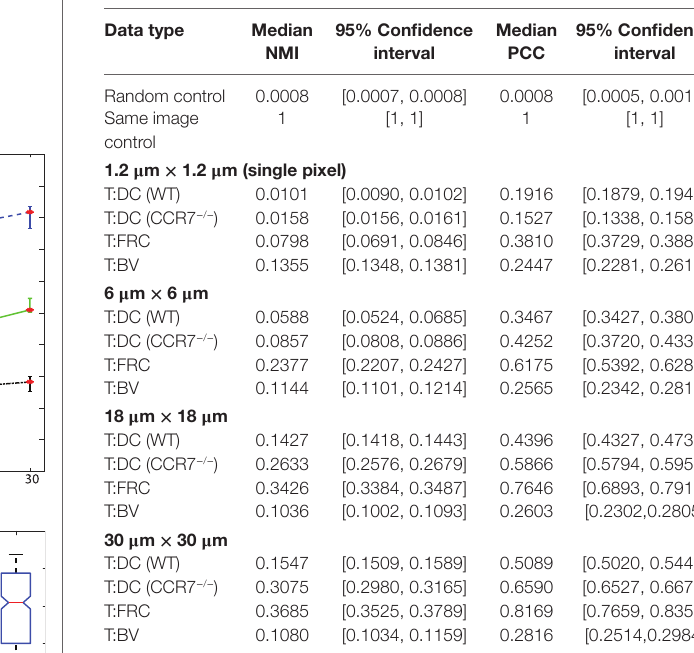
TaBle 1 | Median NMI and PCC values among cell types with 95% confidence